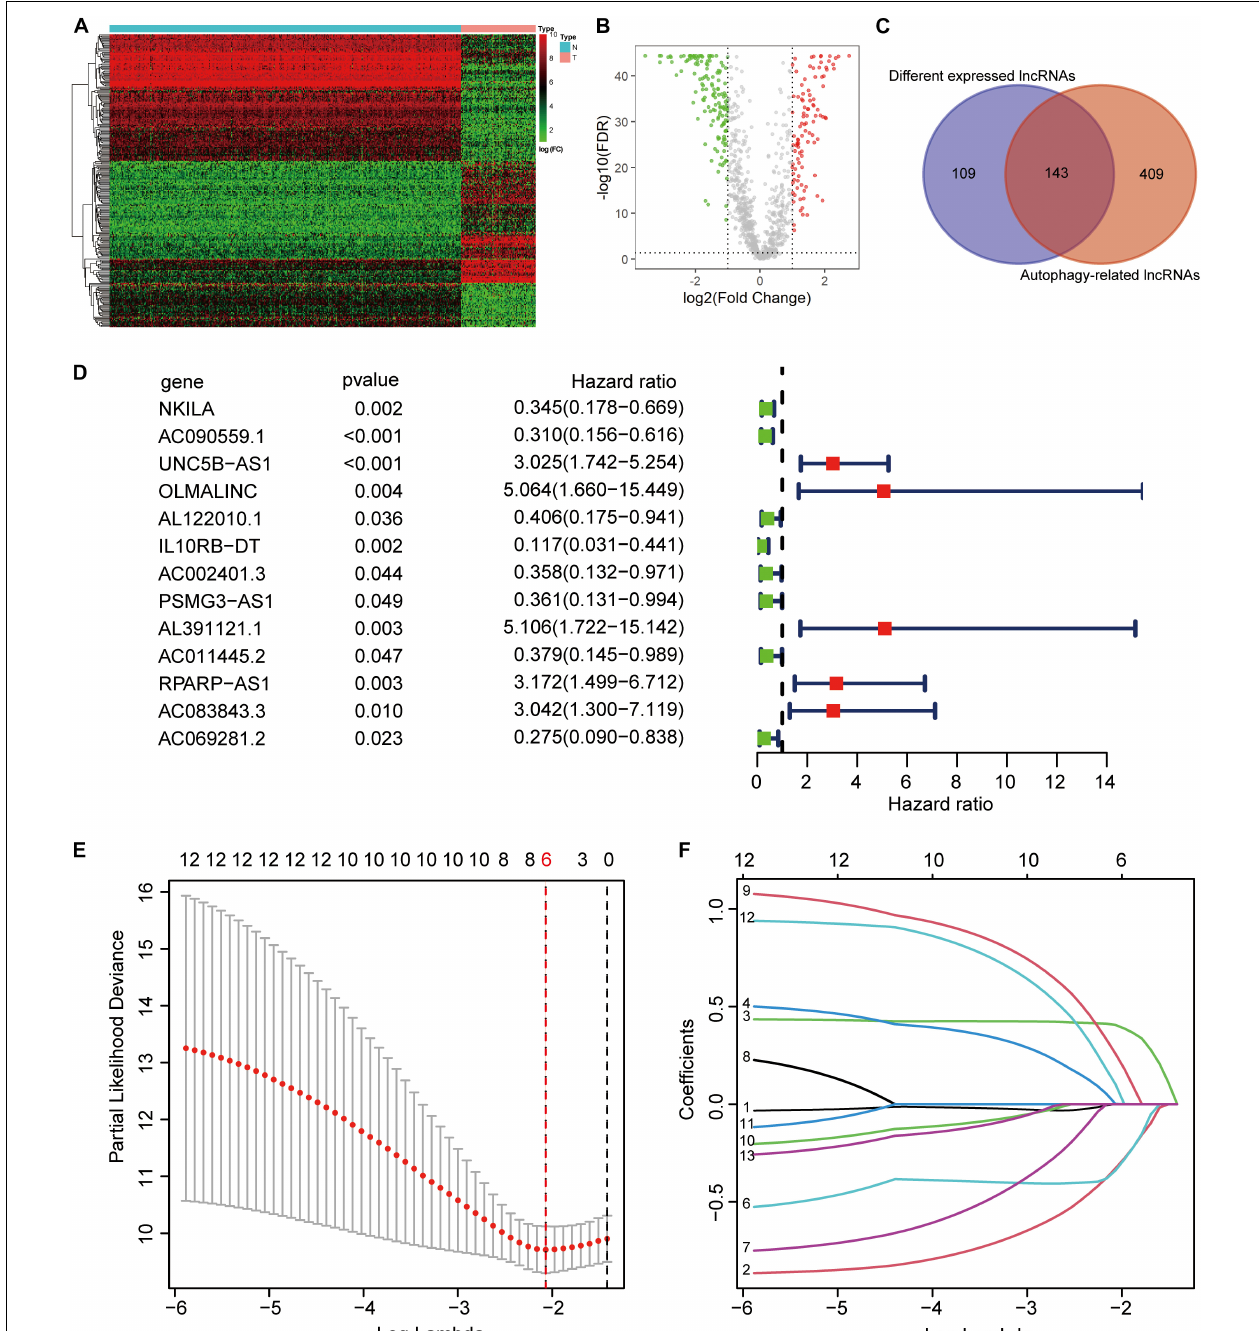
FIGURE 1 | Construction of autophagy-related lncRNA signature. (A) Heatmap of the differentially expression long noncoding RNAs (lncRNAs). (B) Volcano plot. (C) Venn diagram. (D) Univariate cox regression showed 13 lncRNAs related to osteosarcoma survival. (E,F) Lasso regression for lncRNAs in univariate cox regression. Coefficients refers to the risk coefficient corresponding to each